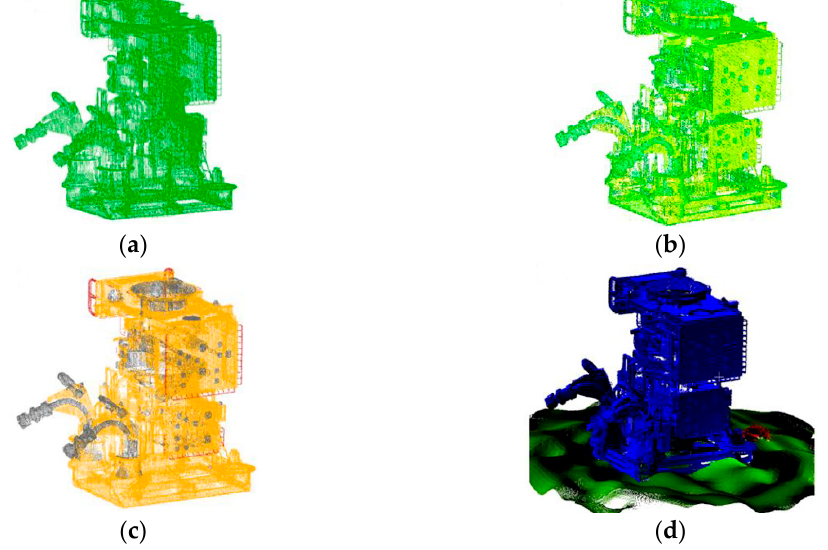
Figure 6. Different properties of the synthetic point cloud: ( a ) 3D points; ( b ) Normal vectors; ( c ) Color;